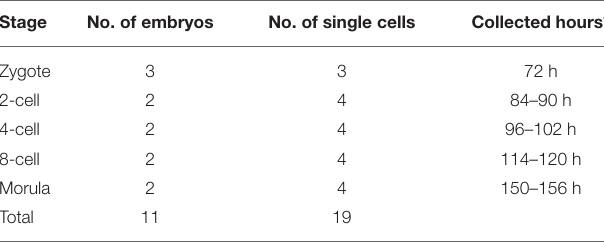
TABLE 1 | Number and collection time of cells for single-cell RNA-seq analysis.